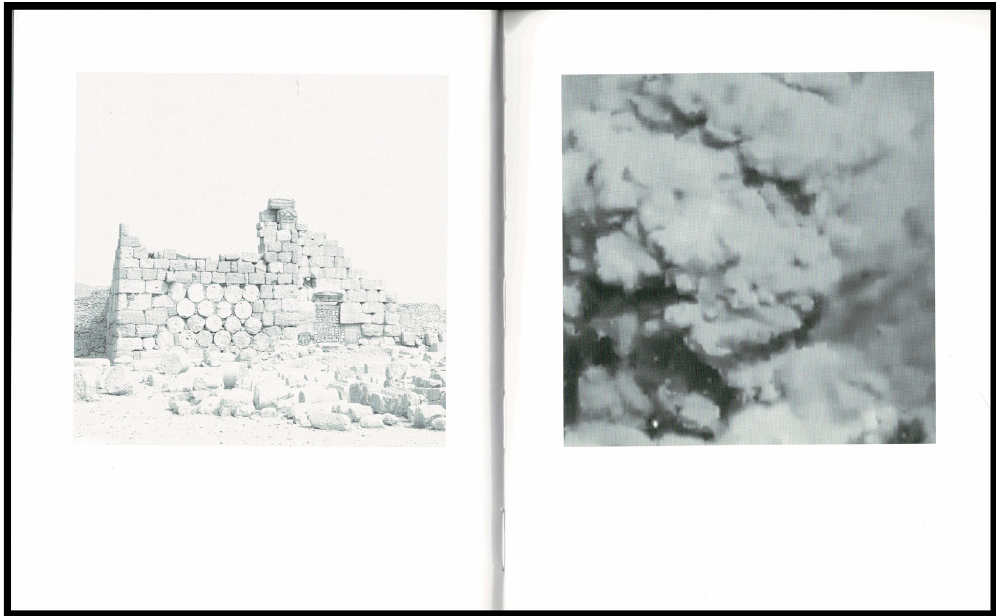
Fig. 4 Author, year, Palmyra. In (Gatti,